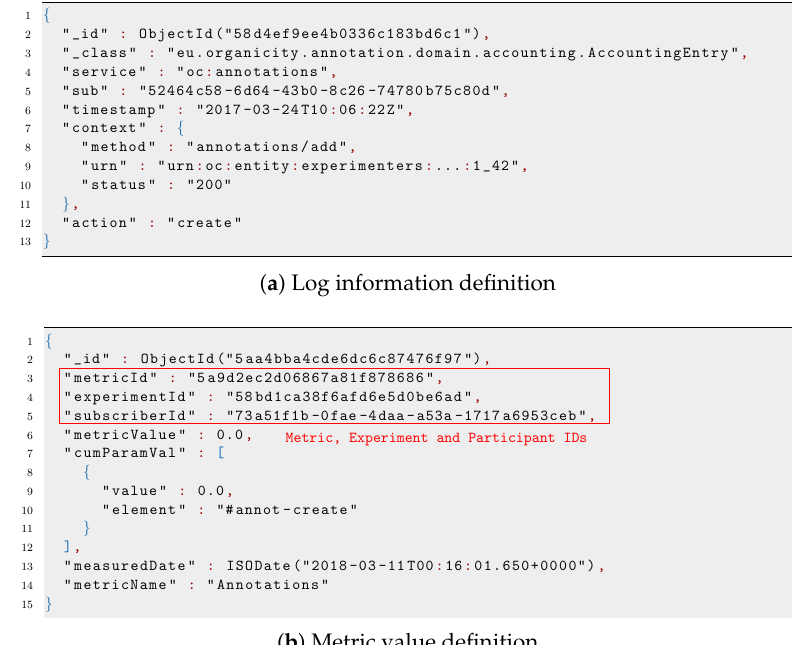
Figure 5. Description of the logging system. Currently the annotations, discovery services provide the system with the logs to define metrics.